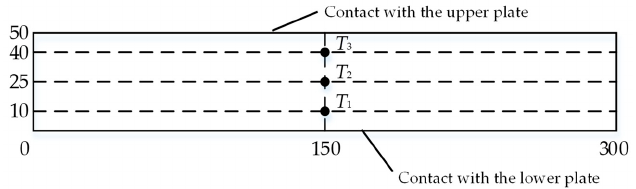
Figure 4. The location of the thermocouples in the specimen.